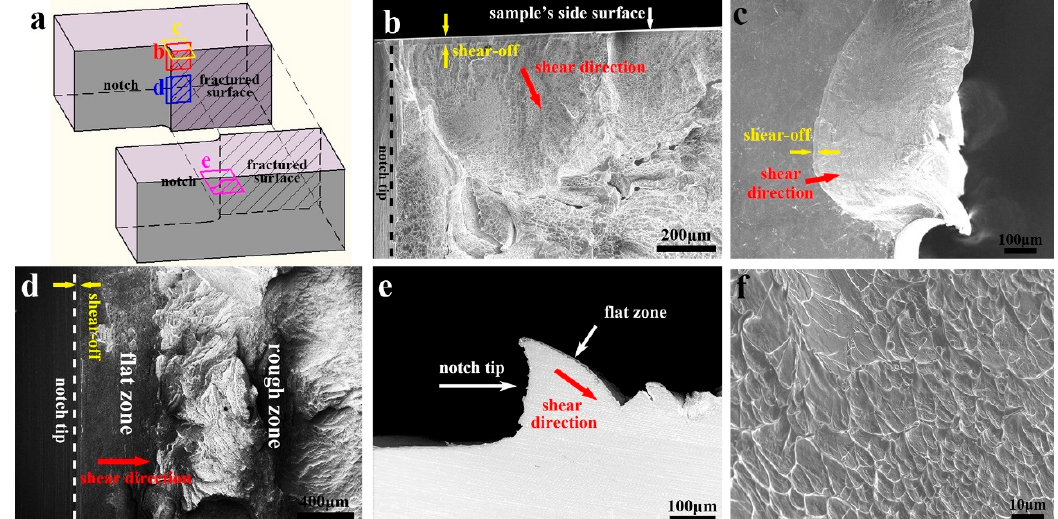
Figure 2. Fractograph of a Pd 77.5 Cu 6 Si 16.5 metallic glass. ( a ) Sketch of the fractured sample with four marked regions. ( b – c ) The fractograph near the side surface of the sample. ( d ) The fractograph inside the sample. ( e ) The cross section profile inside the sample. ( f ) Enlarged image of the viscous features on the fractograph.